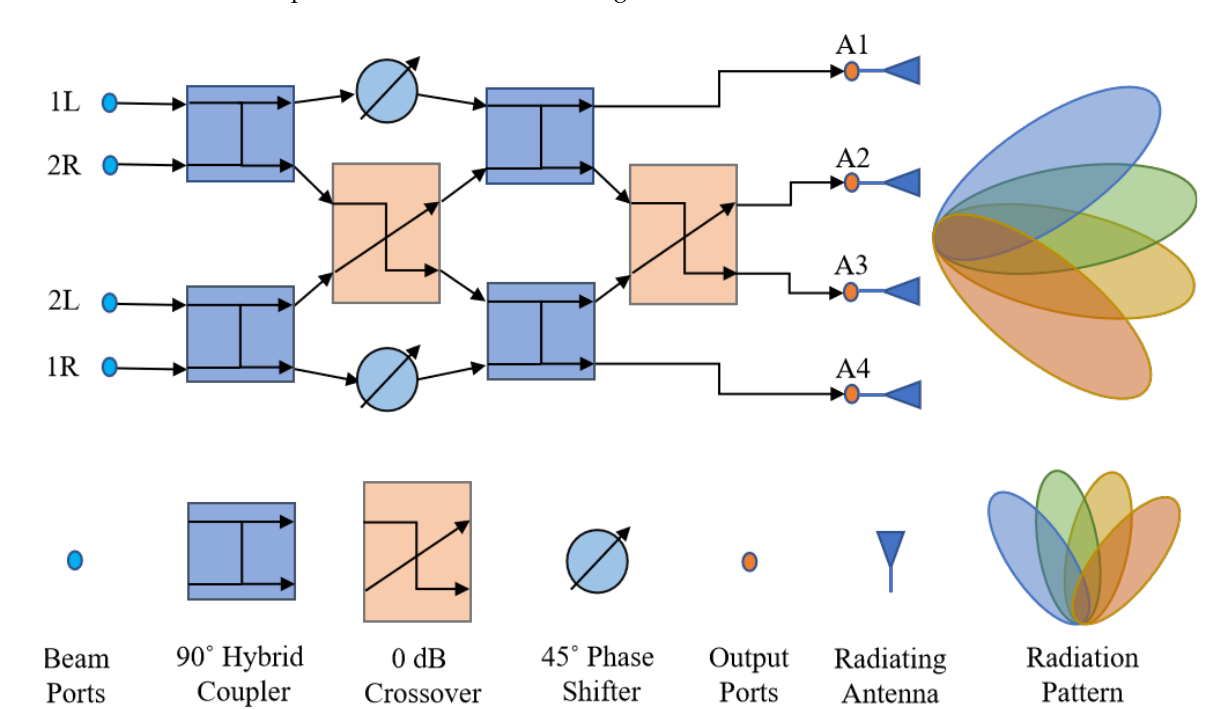
Figure 3. Operational block diagram of 4 × 4 Butler matrix.